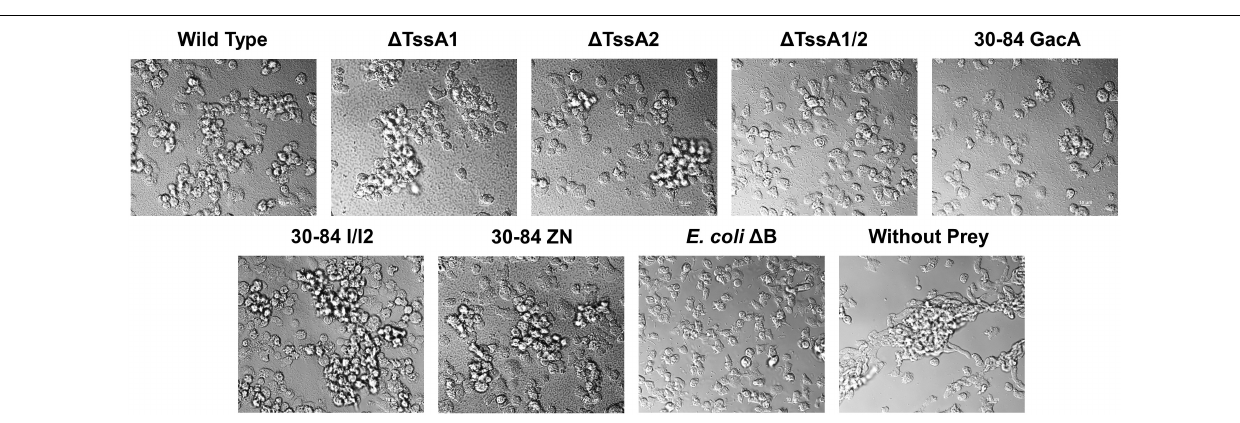
FIGURE 5 | Aggregation behavior of Dictyostelium discoideum grown with different bacterial strains as a food source. Bacteria used as prey in the feeding assay included 30–84 WT, (cid:49) TssA1, (cid:49) TssA2, (cid:49) TssA1/2, 30–84 GacA, 30–84 I/I2, or 30–84 ZN and E. coli (cid:49) B (used as a preferred prey in the lab). D. discoideum without prey bacteria was used as a negative control. D. discoideum cells were grown in 24-well plates in low nutrient PBM media for 24 h and aggregation behavior was observed using DIC microscopy (100X oil). The D. discoideum control (without prey) showed high levels of aggregation caused by stress due to the lack of nutrition in the media. D. discoideum growing with 30–84 WT, (cid:49) TssA1, (cid:49) TssA2, 30–84 I/I2, and 30–84 ZN displayed a similar level of aggregation, indicating that D. discoideum cannot eat these strains. D. discoideum grown with E. coli (cid:49) B showed little to no aggregation. D. discoideum growing with (cid:49) TssA1/2 and 30–84 GacA